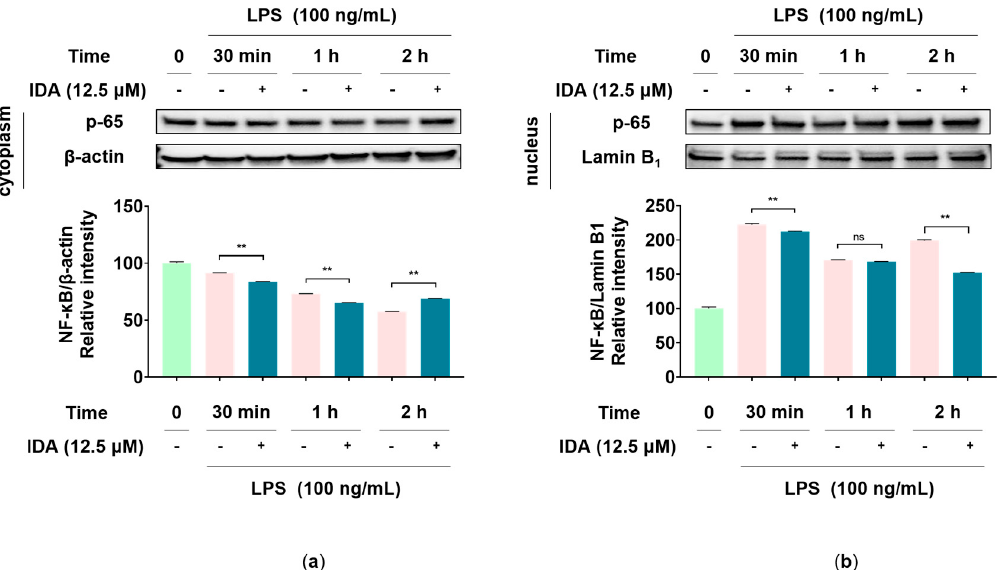
Figure 6. Effect of isodorsmanin A (IDA) on the protein level of the nuclear factor kappa-light-chain- enhancer of activated B cells (NF- κ B)-p65 in the ( a ) cytoplasm and ( b ) nucleus of lipopolysaccharide (LPS)-stimulated macrophages. Cells were pretreated with IDA (12.5 μ M) for 3 h and then stimulated with 100 ng/mL of LPS for different time intervals (30 min, 1 h, and 2 h). Western blot results are from duplicate independent experiments. The results in the graphs are presented as the mean ± standard error from triplicate measurements. Significance was tested using two-way ANOVA followed by Turkey’s post hoc test. ** p < 0.01. ns; not significant.